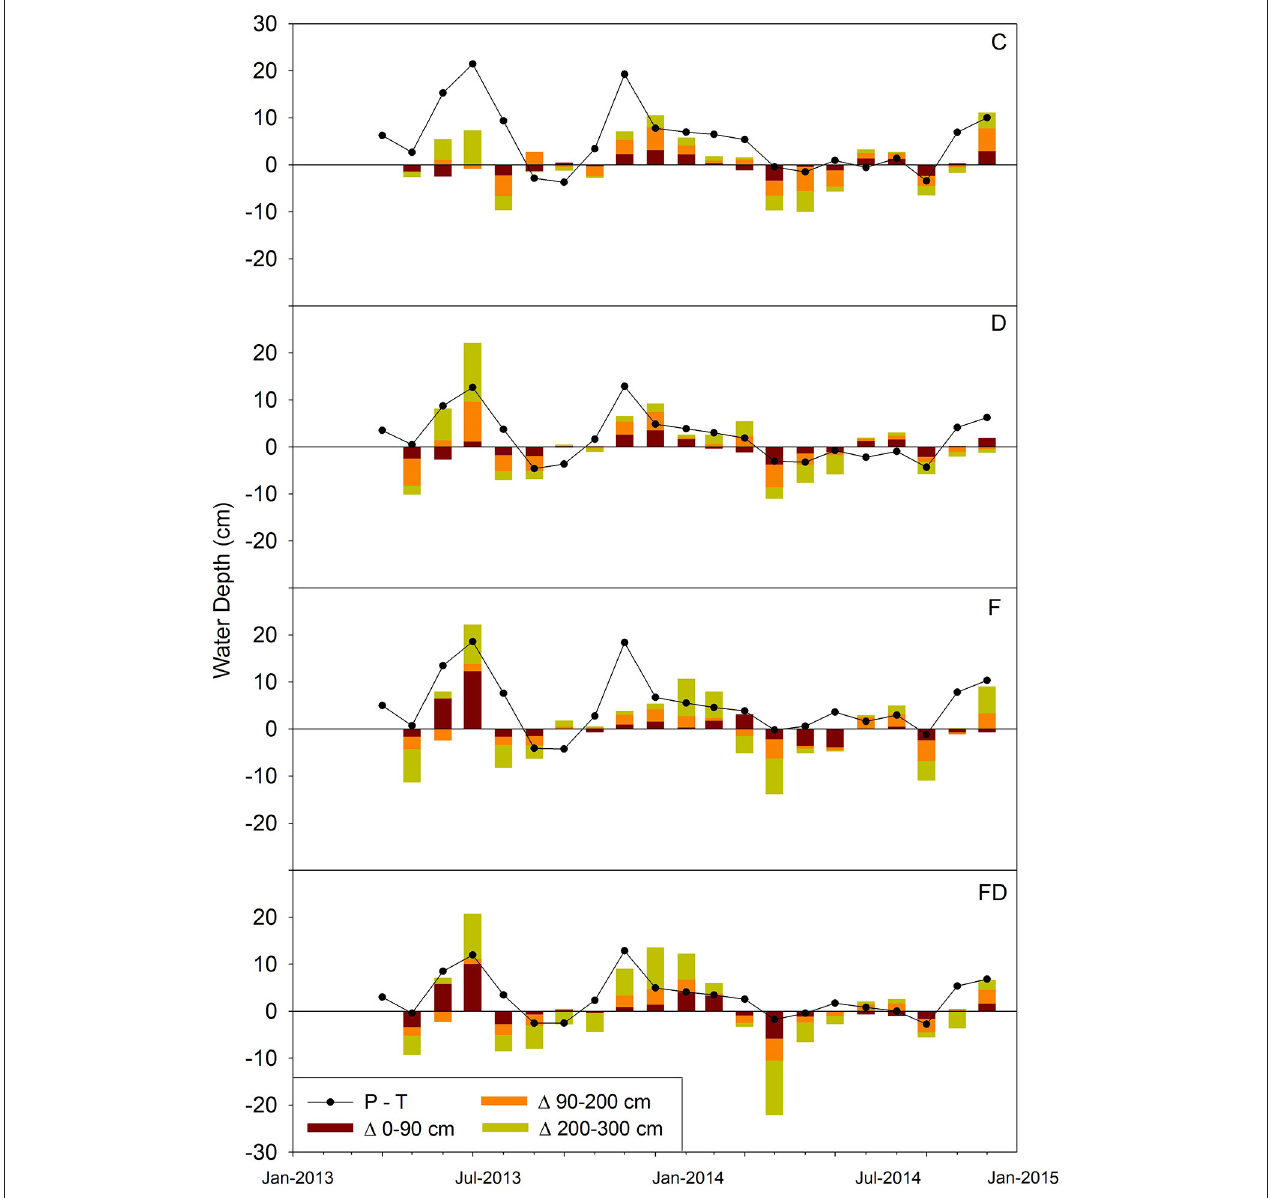
FIGURE 8 | Water mass balance for April 2013 to December 2014. Solid lines are water depth of precipitation—transpiration (P-T). Stacked bars are plant available water storage change by depth. Error bars representing ± 1 SE were too small to show ( n = 4). Treatments are control (C), fertilization (F), throughfall reduction (D), and combined treatment of